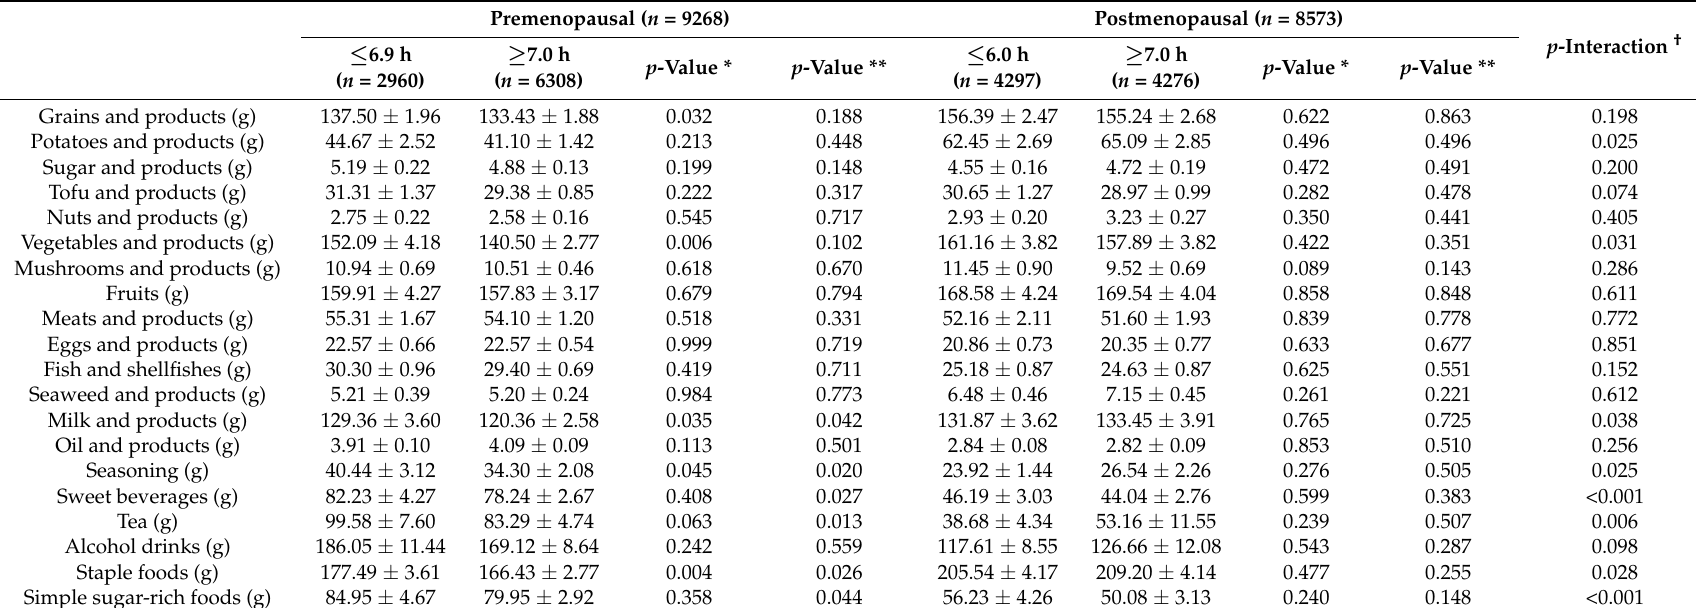
Table 4. Food group consumption according to sleep duration in participating Korean